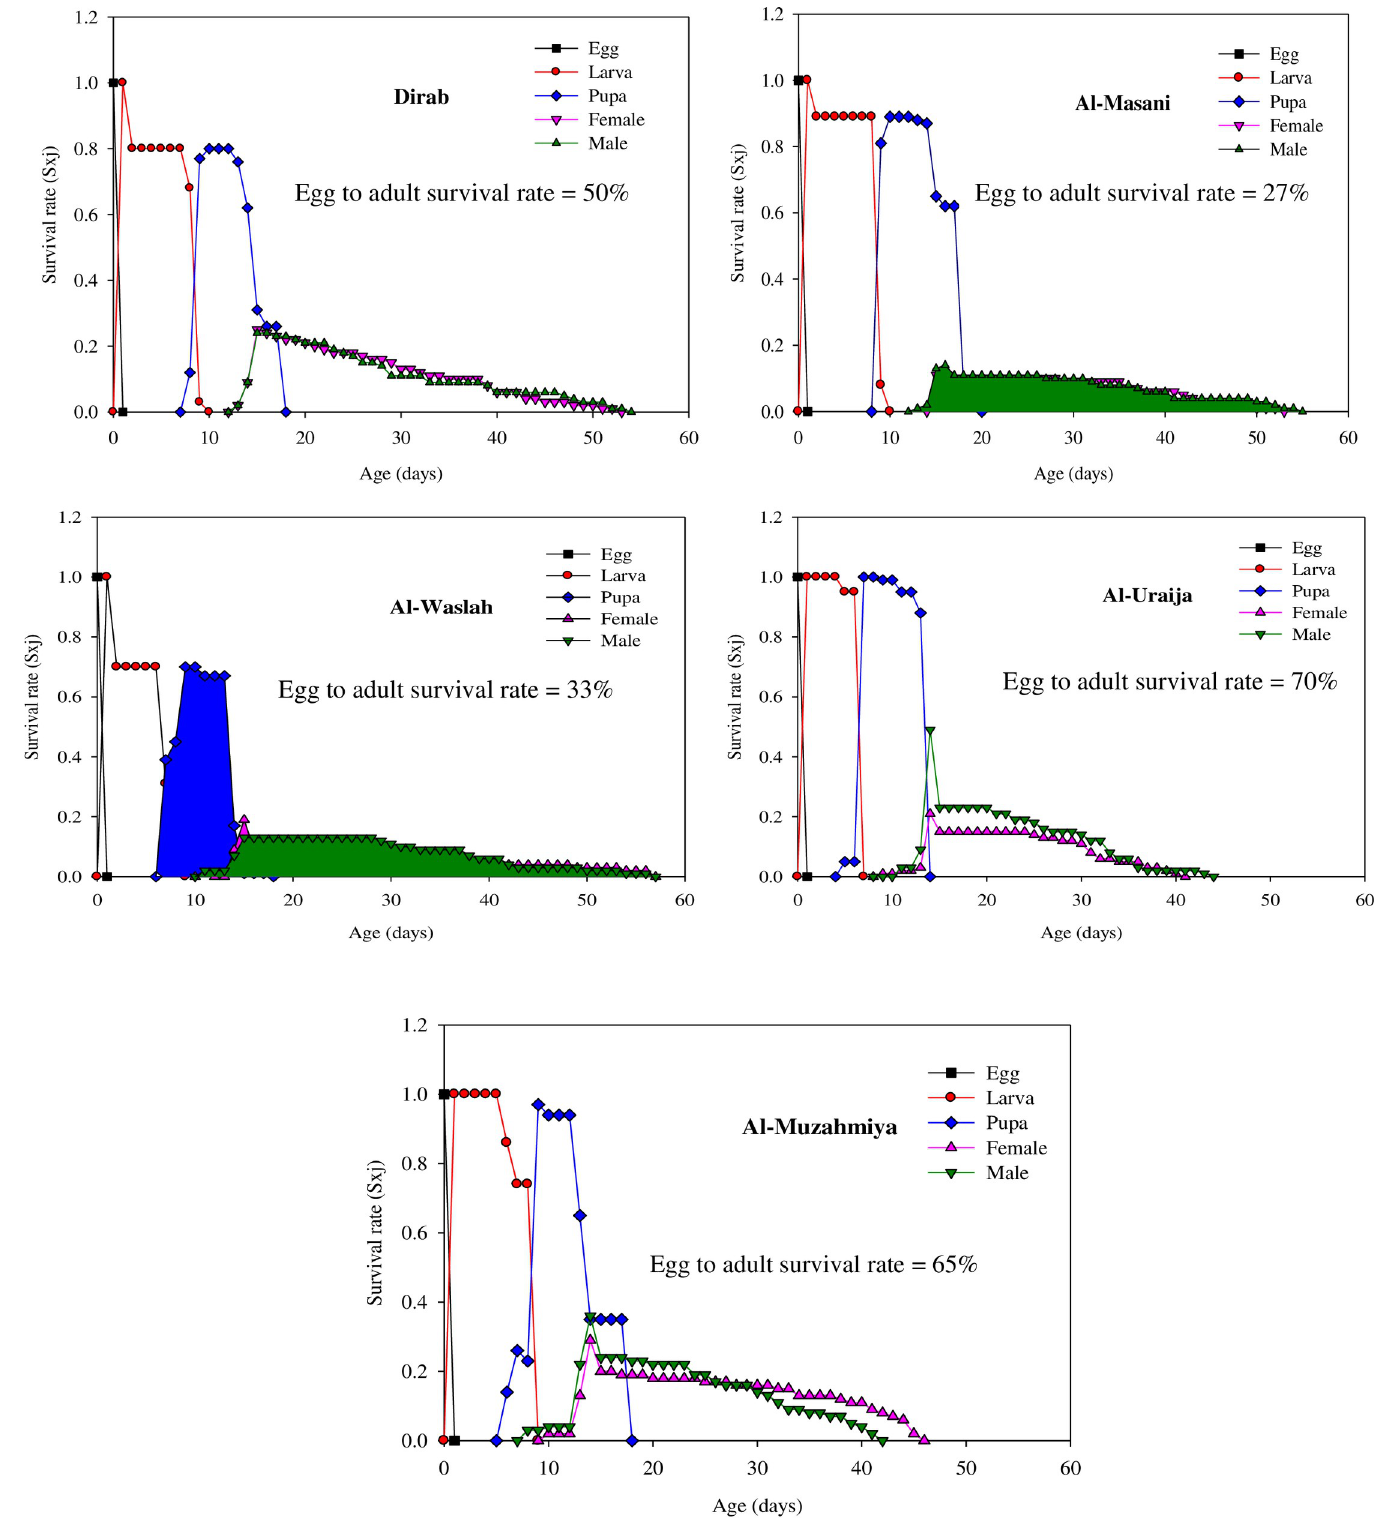
Fig 1. Age-stage-specific survival rate (s xj ) for the Dirab, Al-Masanie, Al-Washlah, Al-Uraija, and Al-Muzahmiya populations of house fly.